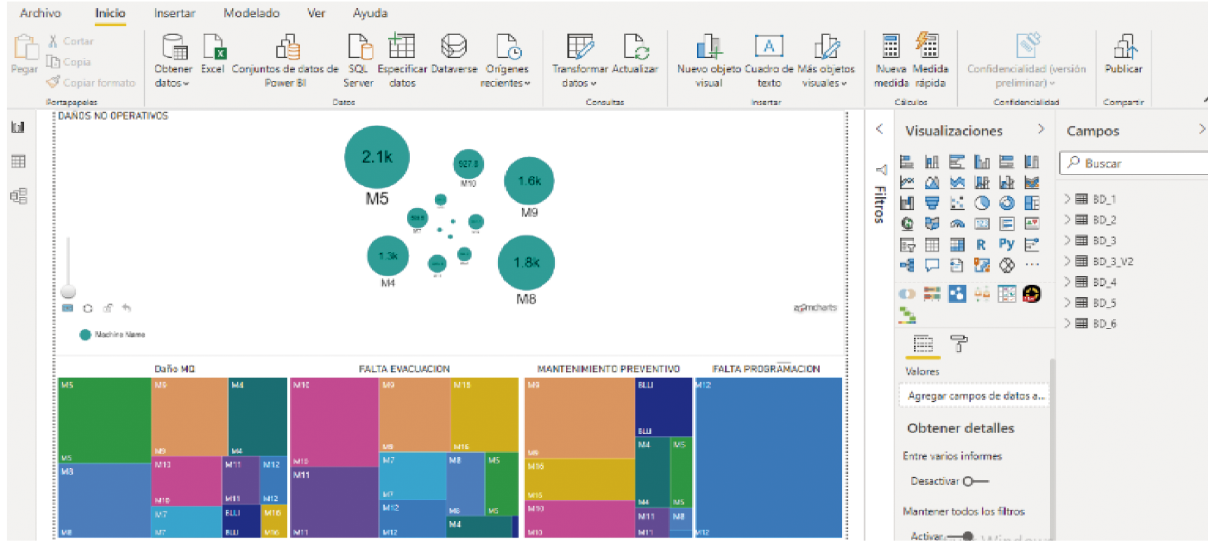
Figure 7. Matrix databases example in Power